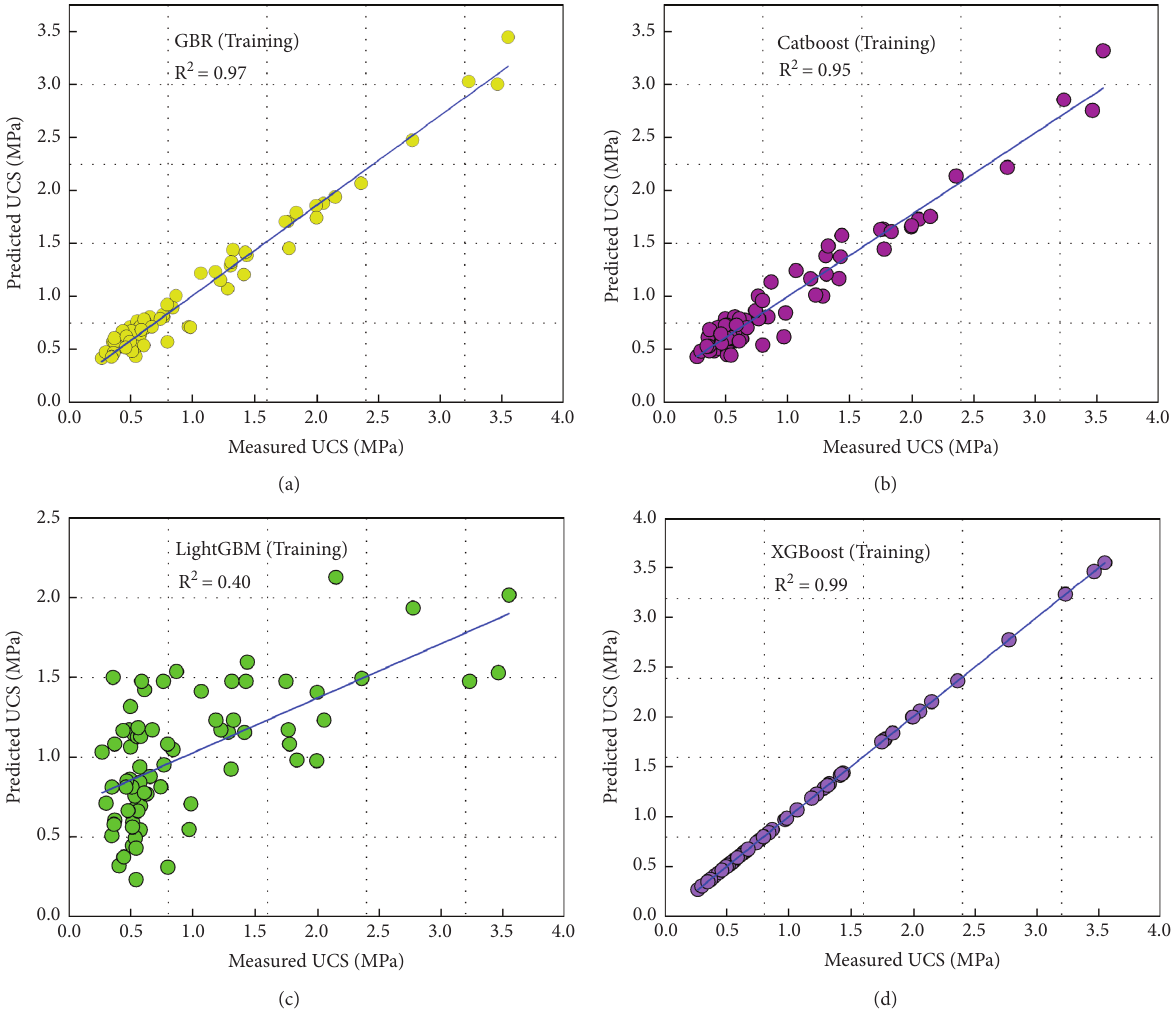
Figure 9: Scatter plots of predicted UCS as opposed to measured UCS of different models in the training stage: (a) GBR, (b) Catboost, (c) LightGBM, and (d)